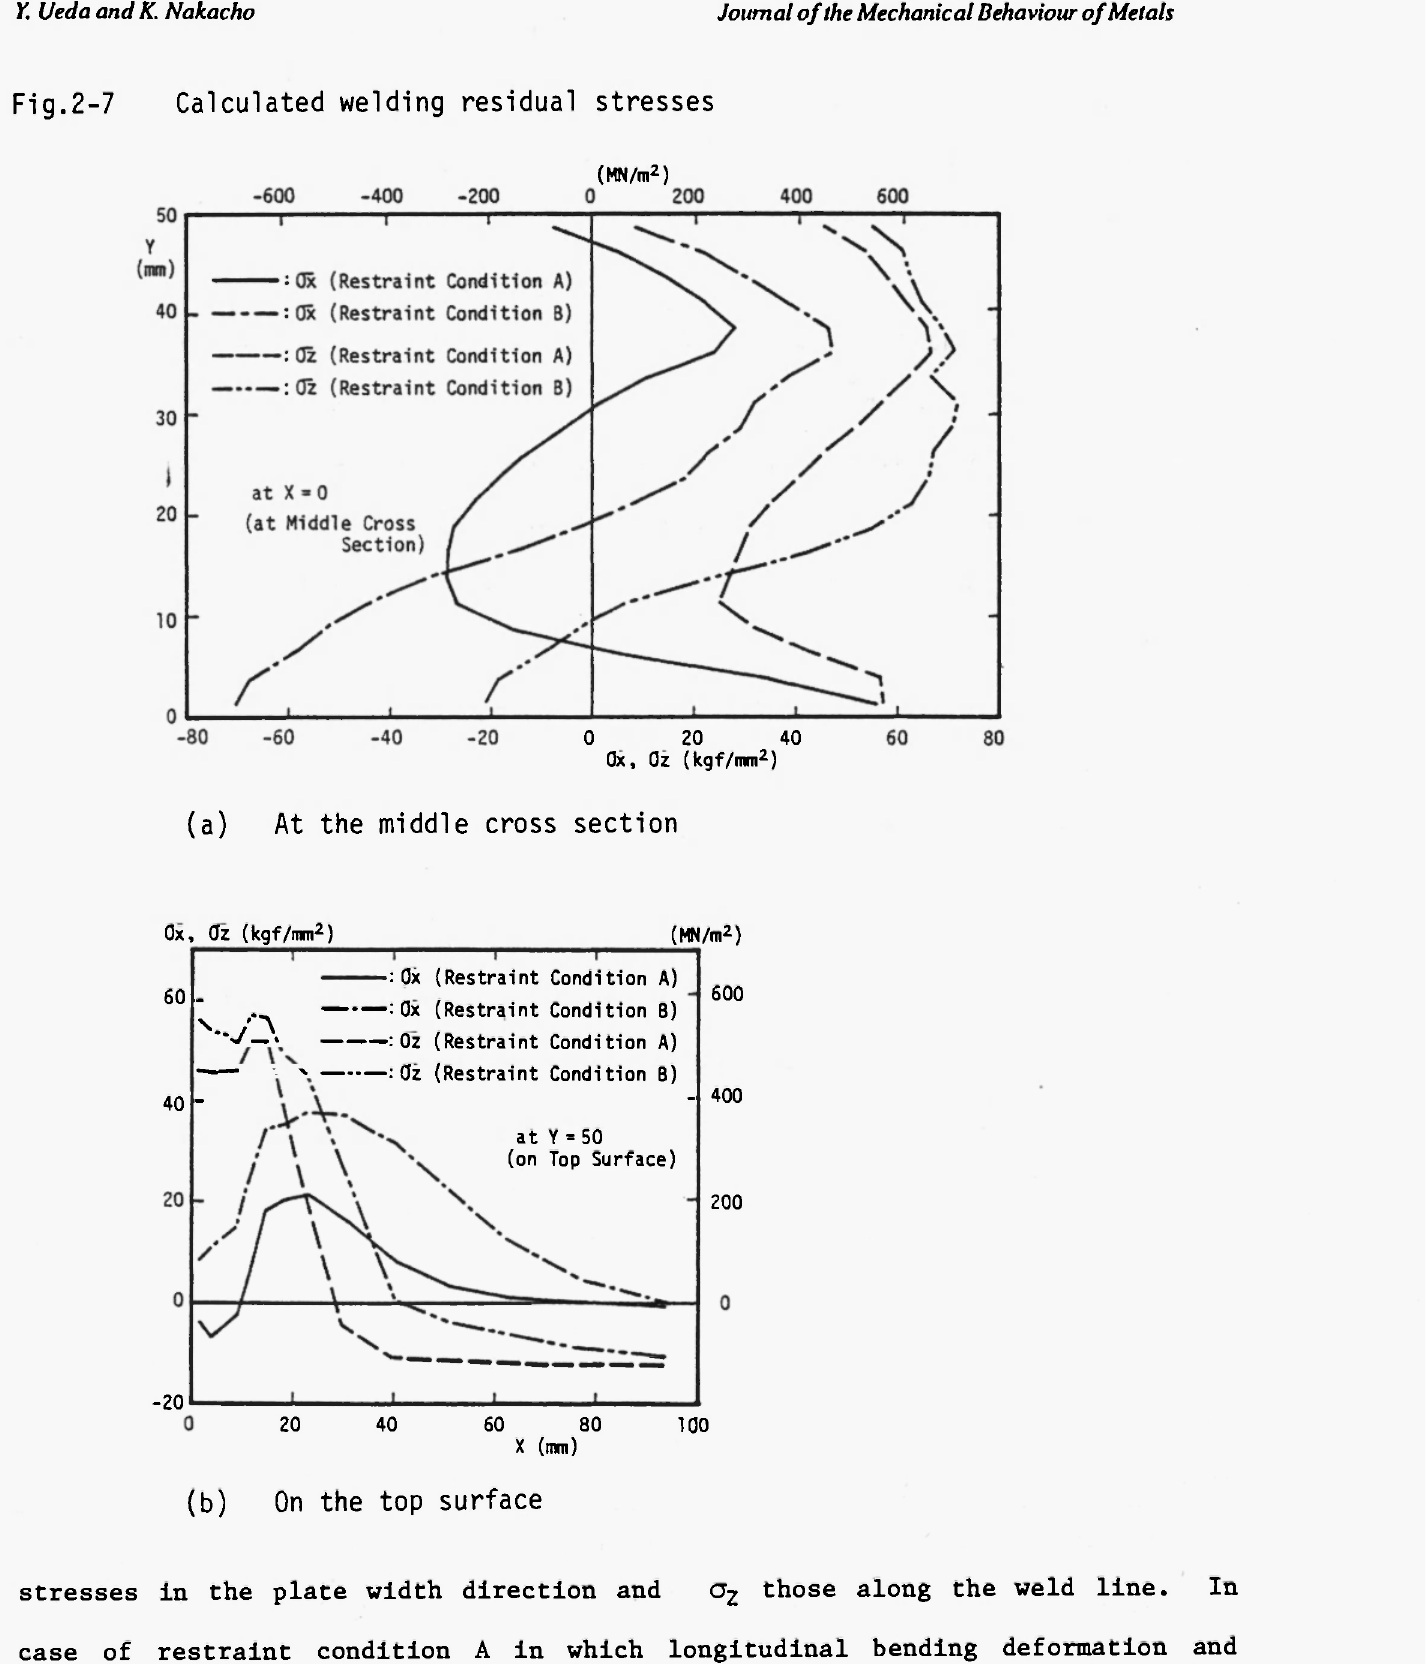
Fig.2-7 Calculated welding residual